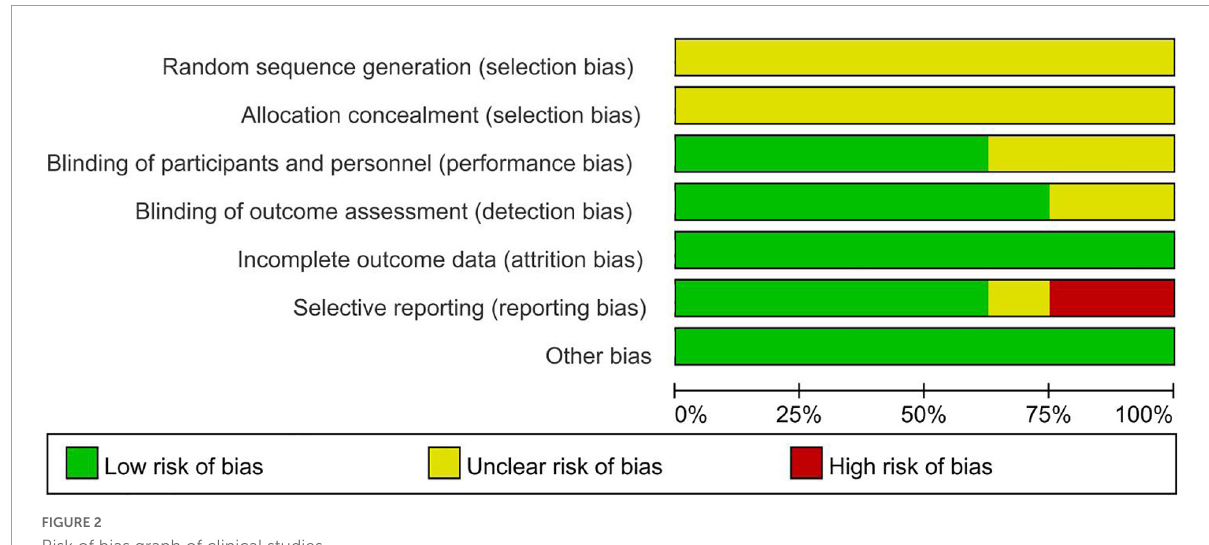
FIGURE2 Risk of bias graph of clinical